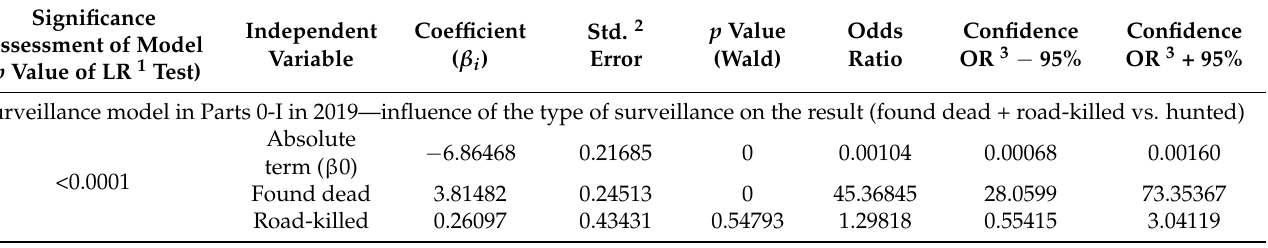
Table 5. Results logistic regression models. Surveillance model in Parts 0-I in